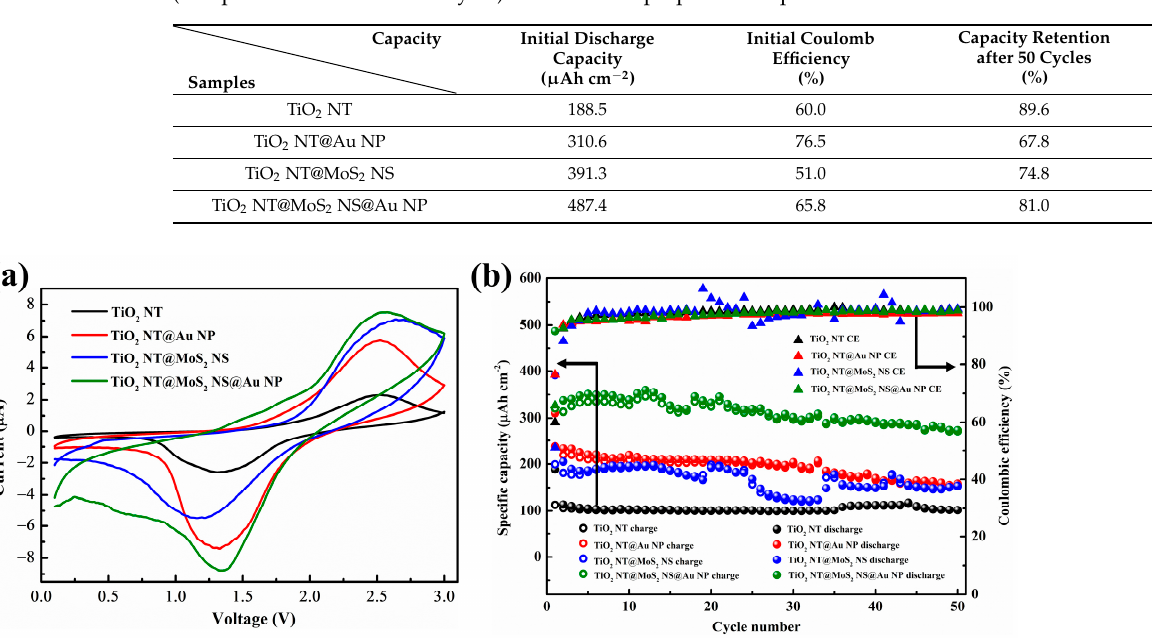
Figure 7. ( a ) Third cycle CV curves, as well as ( b ) the cycling stability and coulomb e ffi ciency